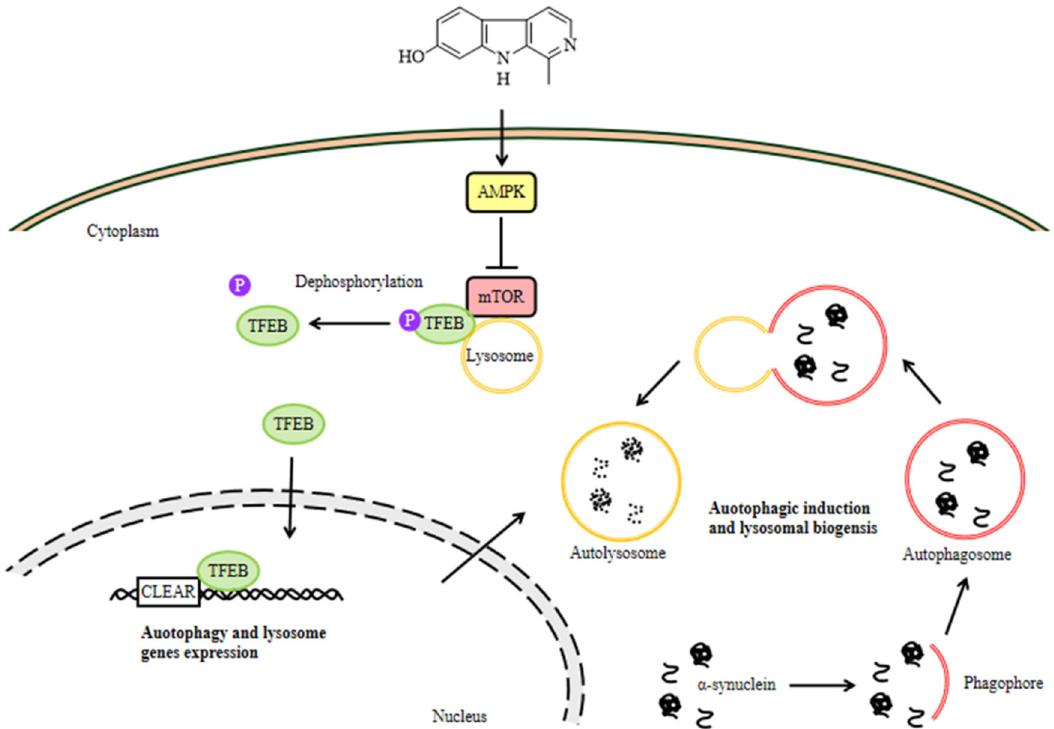
Fig. 8 Underlying mechanisms by which harmol degrades α -syn. Harmol activates the AMPK and inhibits the mTOR. Cytoplasmic TFEB is highly phosphorylated and located in the lysosomal membrane, which binds with mTOR. Harmol inhibits the mTOR activity and promotes the dephosphorylation of TFEB. Dephosphorylated TFEB translocates into the nucleus, where it binds to the CLEAR sequence, leading to upregulation of the autophagic and lysosomal genes. Eventually, harmol enhances the autophagy-lysosome process and promotes the degradation of α